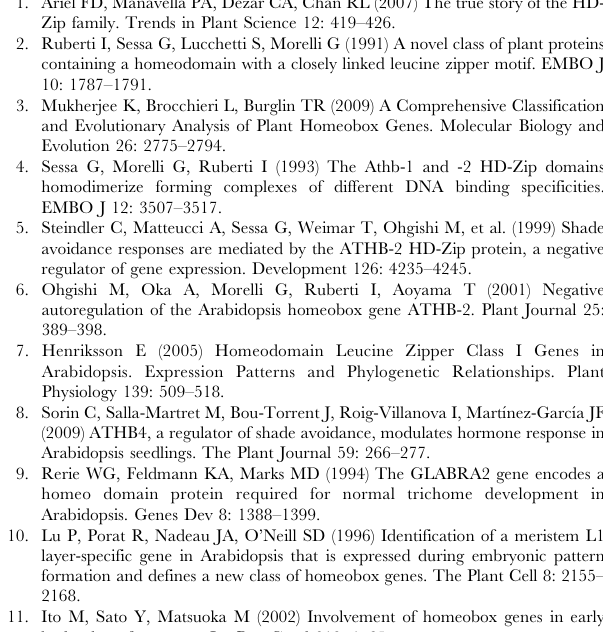
model (as described in Materials and Methods), analyzing by year, by hybrid, by location. Table S3 Dry matter accumulation in ATHB17 events and in control at R1 development stage. Two independent ATHB17 events in three genetic backgrounds were used in physiological studies conducted in 2011 and 2012 under standard agricultural practices (SAP). Data shown is for each hybrid in a given year by location using a fixed effects model (as described in Materials and Methods) to analyze dry matter accumulation data collected at R1. Ear partitioning coefficient was calculated by dividing ear dry weight by total dry weight and analyzed as described above. LSmean for the events and wild type control plants are shown in the table with respective delta, % delta and P-